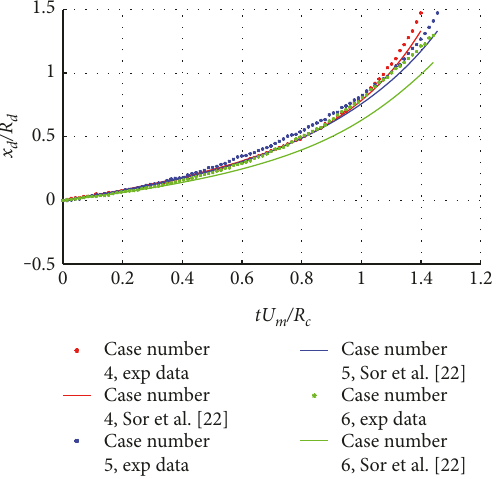
Figure 19: Comparison of the recorded droplet ’ s horizontal position for cases #4, #5, and #6 with those obtained by integrating the theoretical model presented by Sor et al. [22].